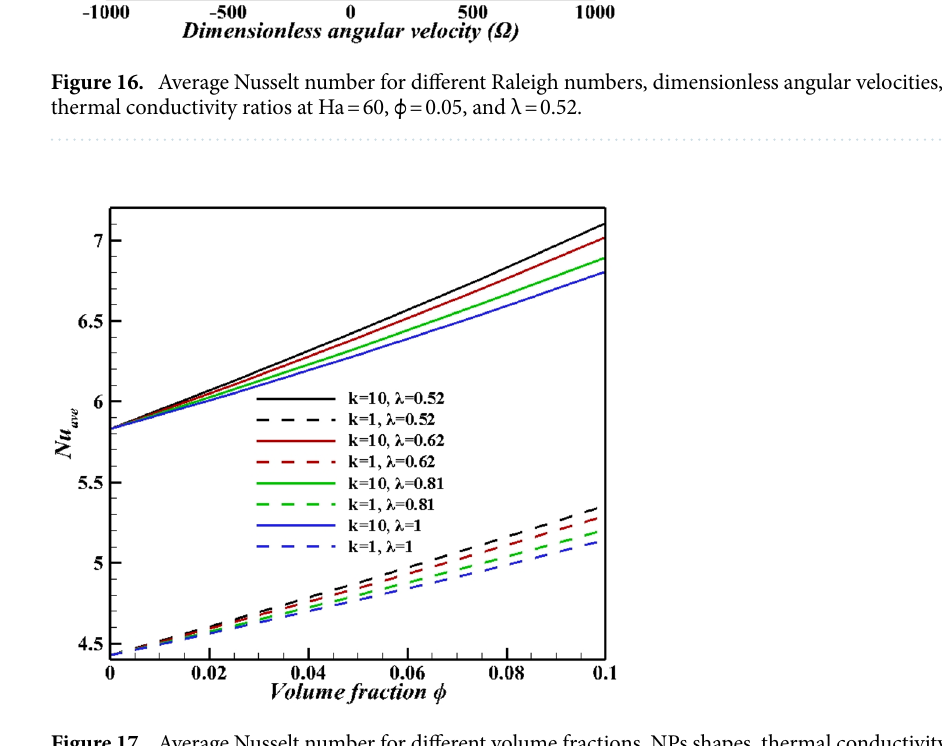
Figure 17. Average Nusselt number for different volume fractions, NPs shapes, thermal conductivity ratios at Ra = 10 5 , Ha = 60, = 0.05, and Ω = ϕ